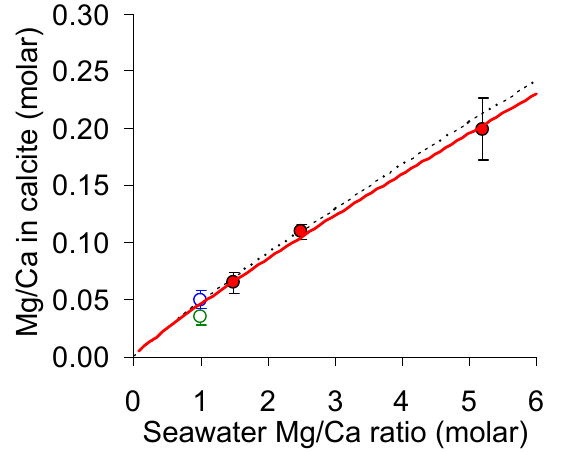
a mMg/Ca=1.0, [Ca 2 + ]=31.6mmolkg-SW − 1 ; mMg/Ca=1.5, [Ca 2 + ]=25.3mmolkg-SW − 1 ; mMg/Ca=2.5, [Ca 2 + ]=18.1mmolkg-SW − 1 ;